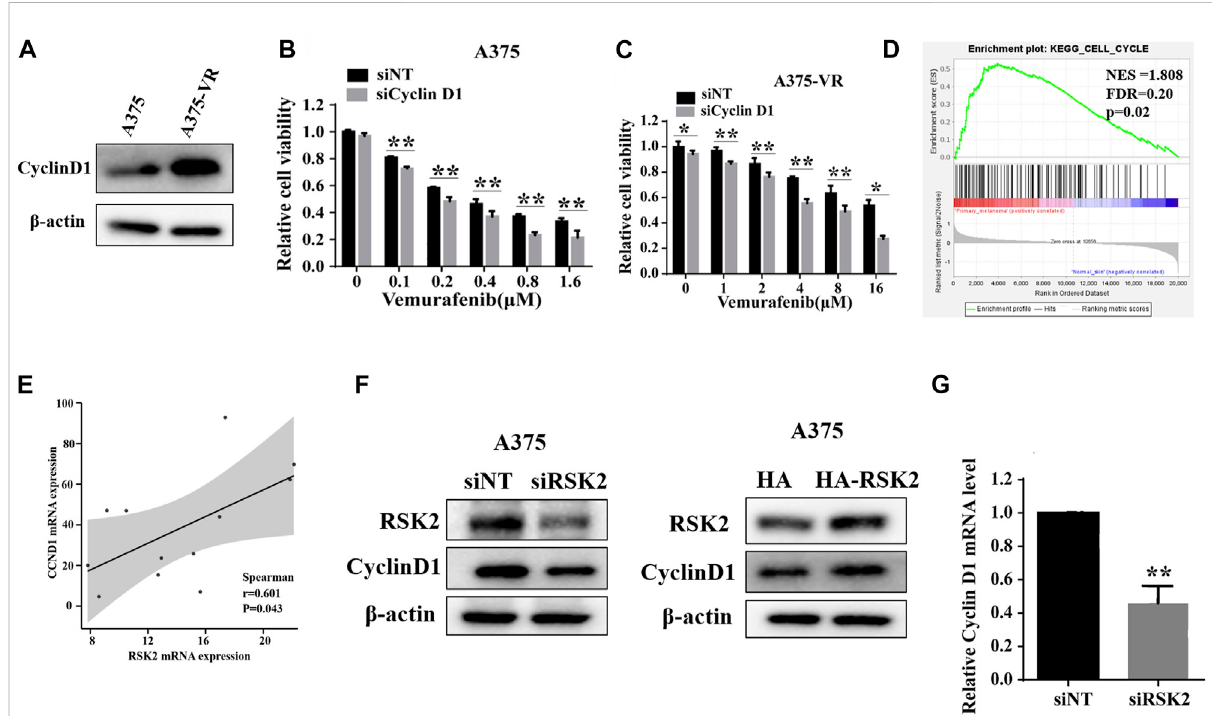
RSK2 induces vemurafenib resistance through upregulating cyclin D1 expression. (A) The protein levels of cyclin D1 were detected in A375 and A375-VR cells by Western blot. A375 cells (B) and A375-VR cells (C) were transfected with siNT or si CyclinD1, cell viability was assessed by CCK-8 assay. (D) Enrichment plots from gene set enrichment analysis (GSEA) of RSK2 in cell cycle by GEO dataset GSE15605. (E) The correlation between RSK2andCCND1predictedbyGEOdatasetGSE77940. (F)